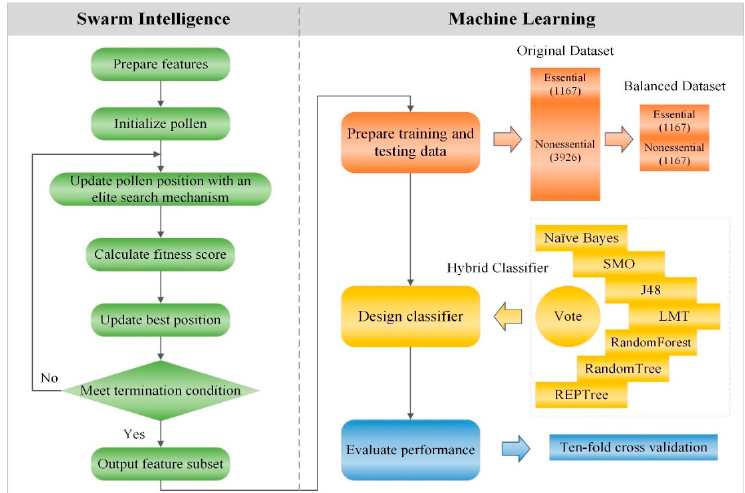
Figure 1. The system flowchart of Elite Search mechanism-based Flower Pollination Algorithm (ESFPA) feature selection strategy to predict protein essentiality.